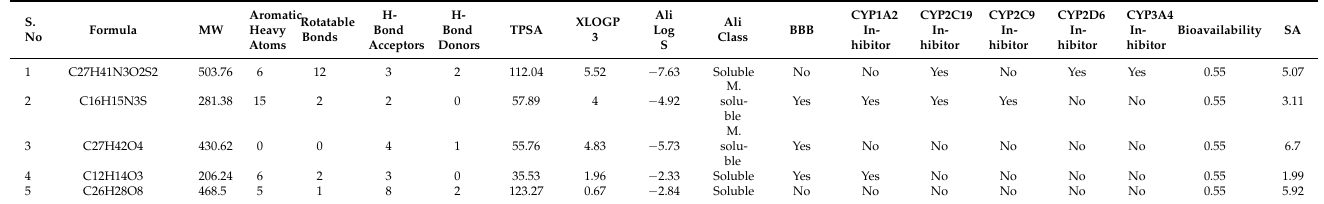
Table 2. ADMET and physicochemical properties of the title